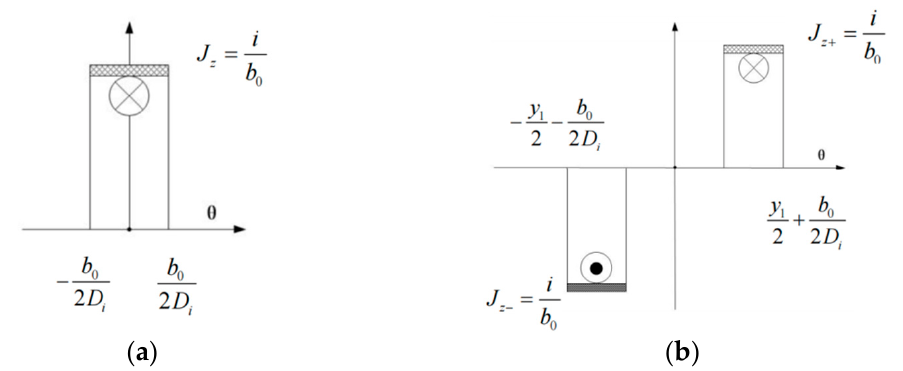
Figure 2. The single conductor and single coil current sheet distribution model: ( a ) single conductor; ( b ) single coil.